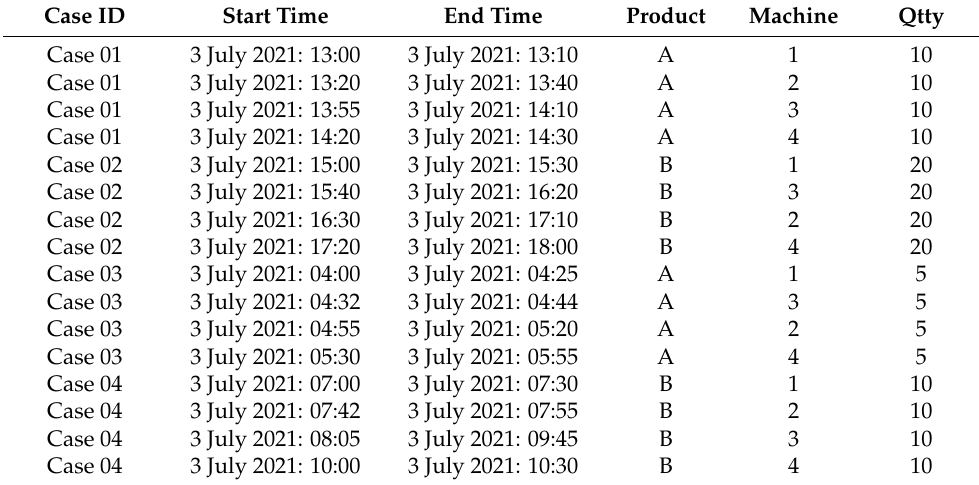
Table 1. Fragment of an